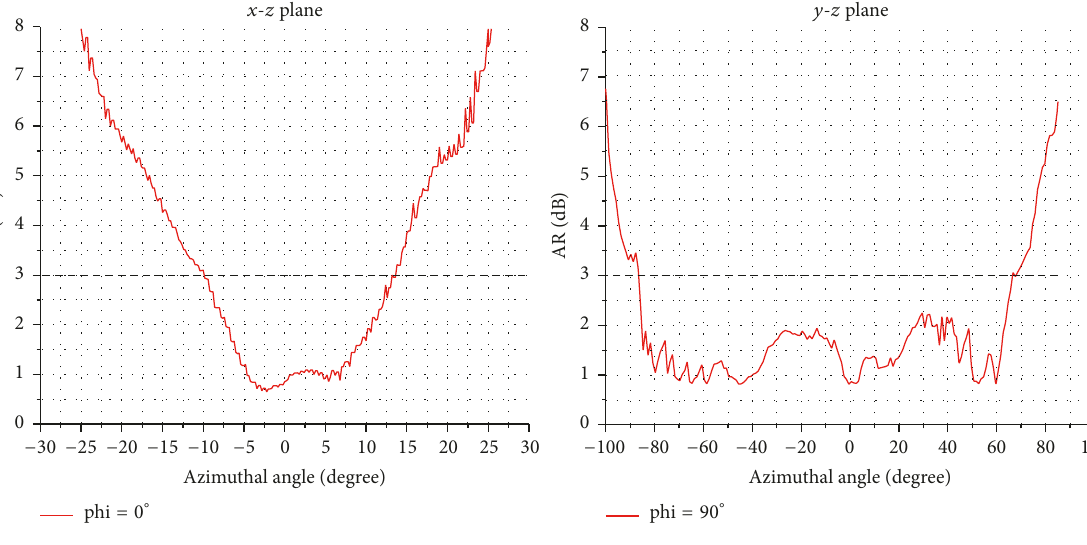
Figure 14: Measured AR against azimuth angle of the 1 × 2 linear